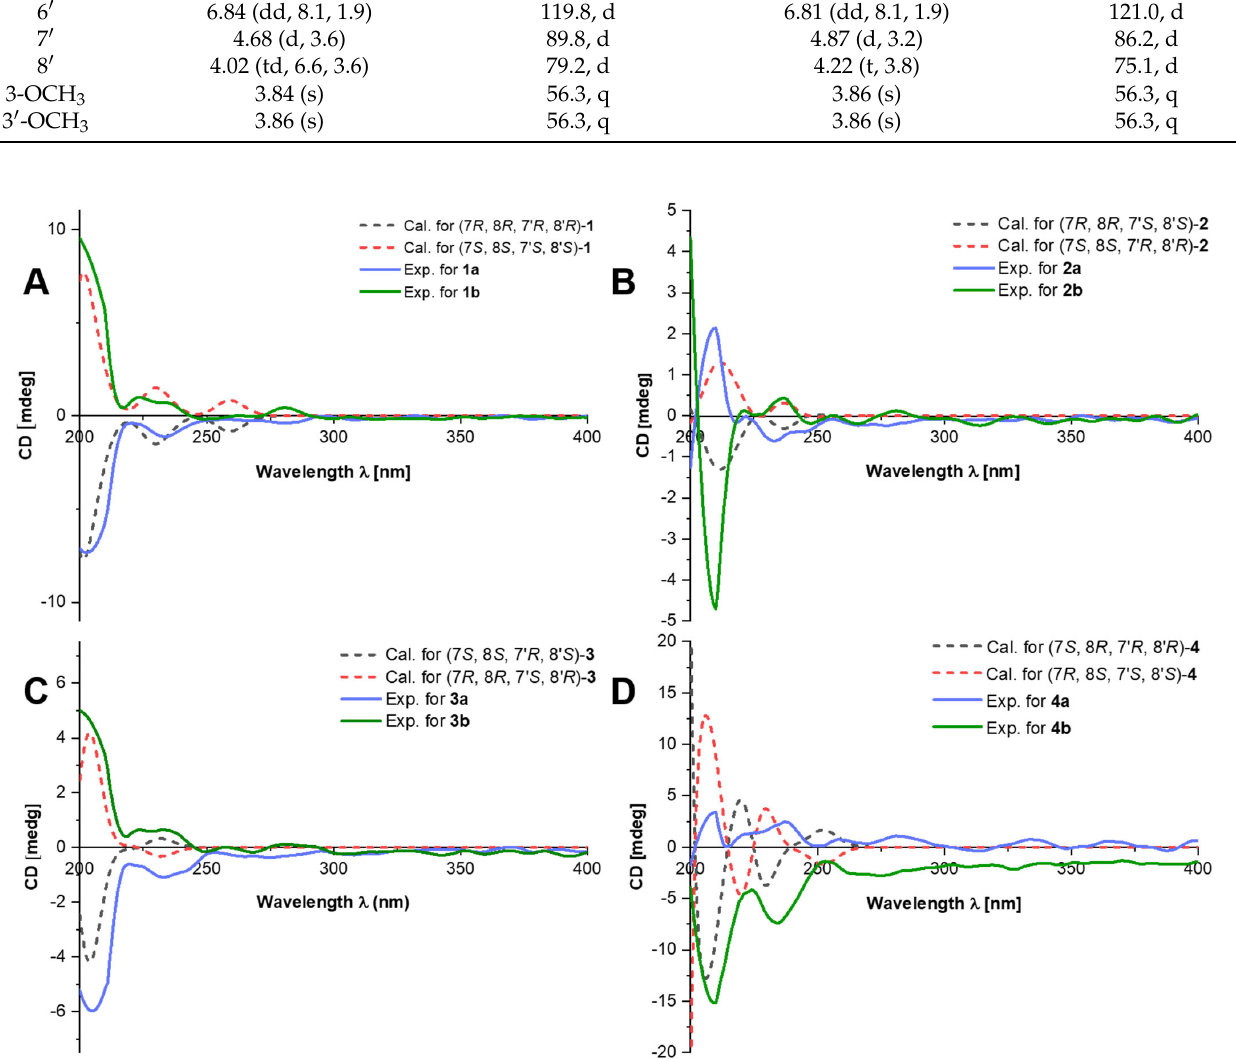
Figure 3. Comparison of the calculated ECD and experimental spectra in MeOH. ( A ) The calculated ECD spectra of (7 R , 8 R , 7 ′ R , 8 ′ R ) ‐ 1 and (7 S , 8 S , 7 ′ S , 8 ′ S ) ‐ 1 at B3LYP/6 ‐ 31G level, σ = 0.30 eV; shift = 3 nm. ( B ) The calculated ECD spectra of (7 R , 8 R , 7 ′ S , 8 ′ S ) ‐ 2 and (7 S , 8 S , 7 ′ R , 8 ′ R ) ‐ 2 at B3LYP/6 ‐ 31G level, σ = 0.22 eV; shift = 11 nm. ( C ) The calculated ECD spectra of (7 S , 8 S , 7 ′ R , 8 ′ S ) ‐ 3 and (7 R , 8 R , 7 ′ S , 8 ′ R ) ‐ 3 at B3LYP/6 ‐ 31G level, σ = 0.25 eV; shift = 18 nm. ( D ) The calculated ECD spectra of (7 S , 8 R , 7 ′ R , 8 ′ R) ‐ 4 and (7 R , 8 S , 7 ′ S , 8 ′ S) ‐ 4 at B3LYP/6 ‐ 31G level, σ = 0.20 eV; shift = 0 nm. 2.2. Biological Evaluation Breast cancer is a kind of malignant cancer. Especially, triple ‐ negative breast cancer (TNBC) is one of the subgroups of breast cancer which has an incidence of 15–20% and many characteristics such as invasive, resistance, and rapid growth rate [25]. Therefore, discovering some potential molecules which can inhibit cell migration of TNBC is of great importance. Previous research has shown that norlignans possessed an anti ‐ tumor poten ‐ tial [19,20]. Inspired by the traditional medicinal applications of F. sinkiangensis , antitumor and wound ‐ healing activities of compounds 1a / 1b – 4a / 4b by using cell proliferation and cell migration assays in TNBC cells and HUVECs were evaluated [17,26]. The results demonstrated that all compounds did not affect the cell viability of TNBC cell lines (Figure 4A). At the same time, compound 3a could significantly inhibit the inva ‐ sion and migration of these two TNBC cell lines. Interestingly, compound 2a exhibits the inhibitory activity on HCC1806 only (Figure 4B–E). The results of assays on HUVECs demonstrate that compounds 4a and 4b could significantly promote cell proliferation (Fig ‐ ure 5A). However, all compounds performed negligible effects on cell migration of HU ‐ VECs (Figure 5B,C). In general, cell proliferation, cell mobility, and tube formation assays are used for evaluating the wound ‐ healing potential of the compounds. In the present study, the tube formation test was not continued due to the negligible effects of the